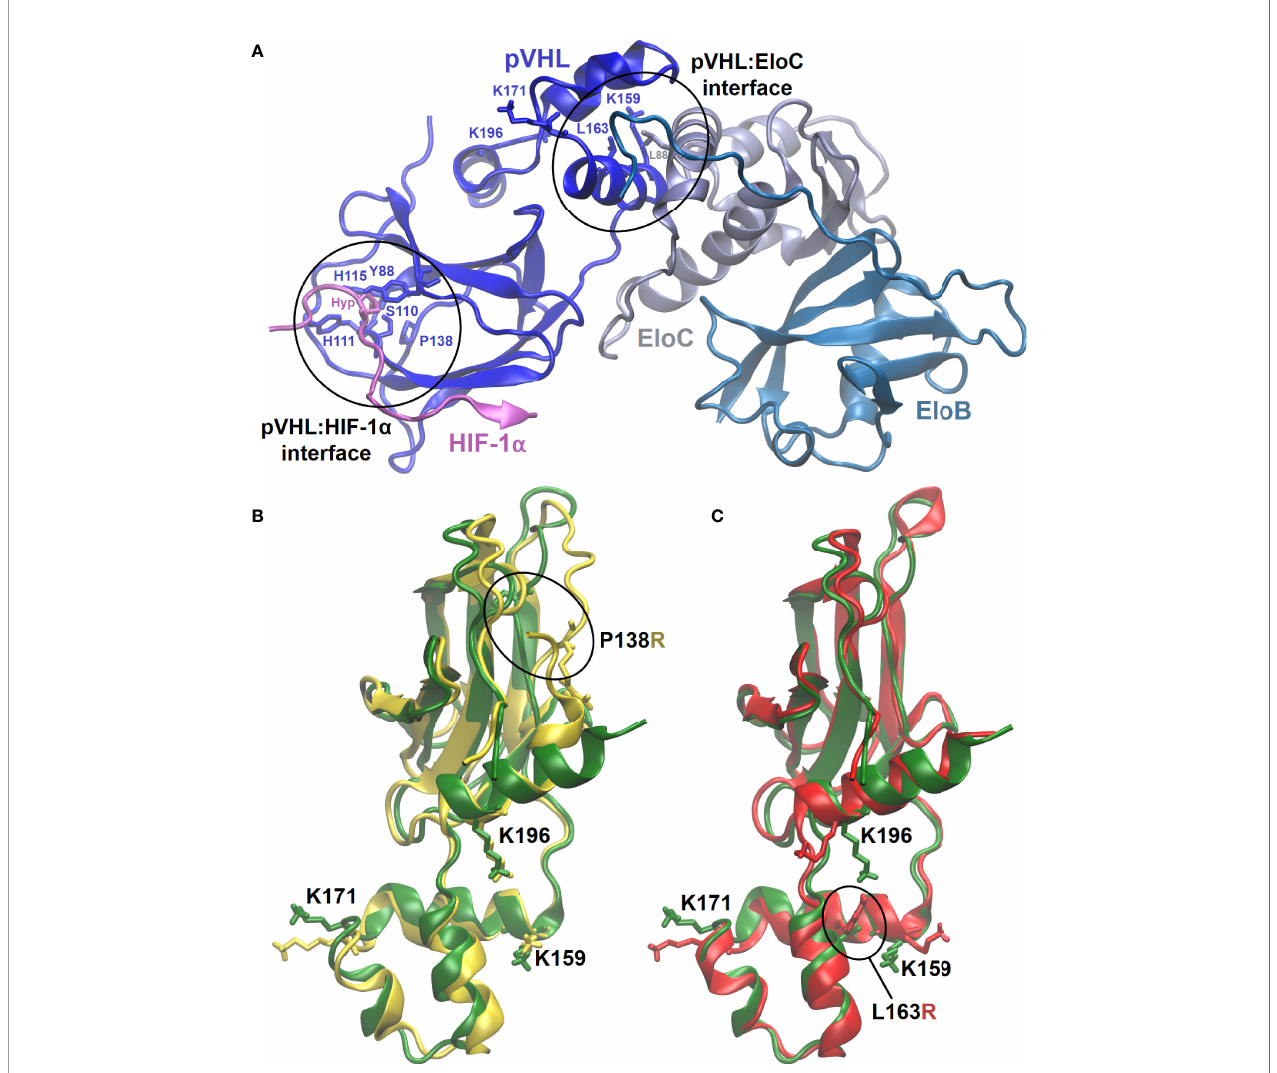
FIGURE 5 | 3D representative structures from MD simulations. (A) VBC complex with pVHL : HIF-1 a and pVHL : EloC interfaces where variants are located circled and evidencing relevant residues. (B, C) Overlapped representative structures for the most populated clusters from 400-ns MD simulation under normoxia. Circled residues correspond to pVHL variants amino acids P138R and L163R in (B, C) , respectively. Color code: green, wild type pVHL; yellow, P138R pVHL variant; red, L163R pVHL variant.